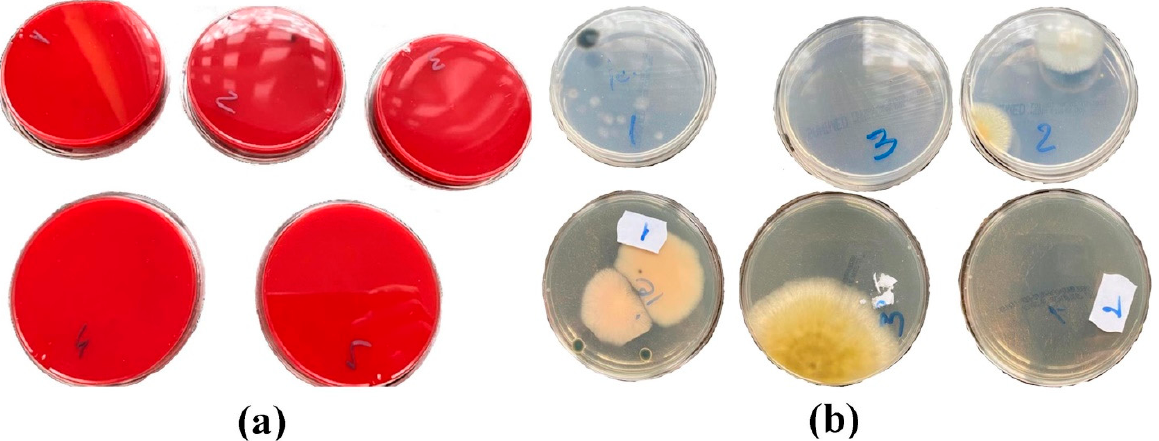
Figure 3. Plates seeded with primary samples (before interventions) on the 10th day of incubation (( a ) dishes with Blood Agar culture environment, samples 1–5; ( b ) dishes with Sabouraud culture (top) and Czapek Dox (bottom) culture environments, samples 1–3).